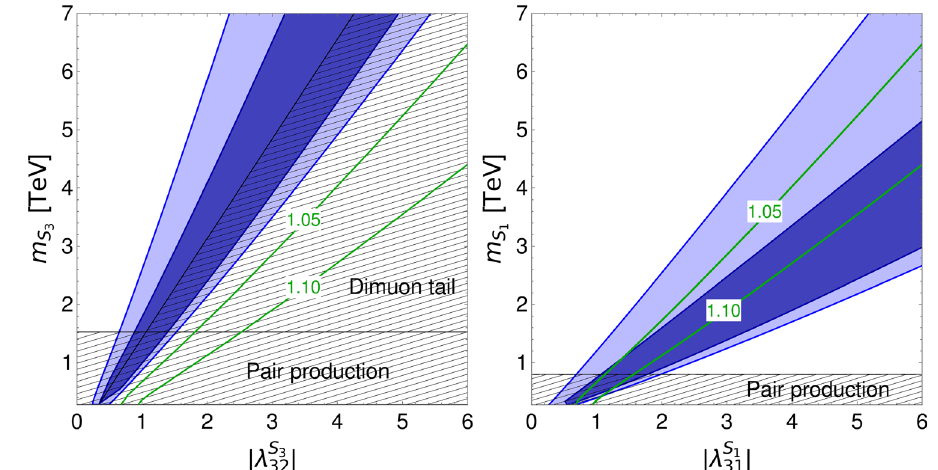
Fig. 5 Parameter space for scalar leptoquarks with a single coupling: S 3 with mass m S and coupling λ S 3 (left panel), and S 1 with mass 32 3 m S and coupling λ S 1 (right panel). Dark (light) blue areas indicate the 31 1